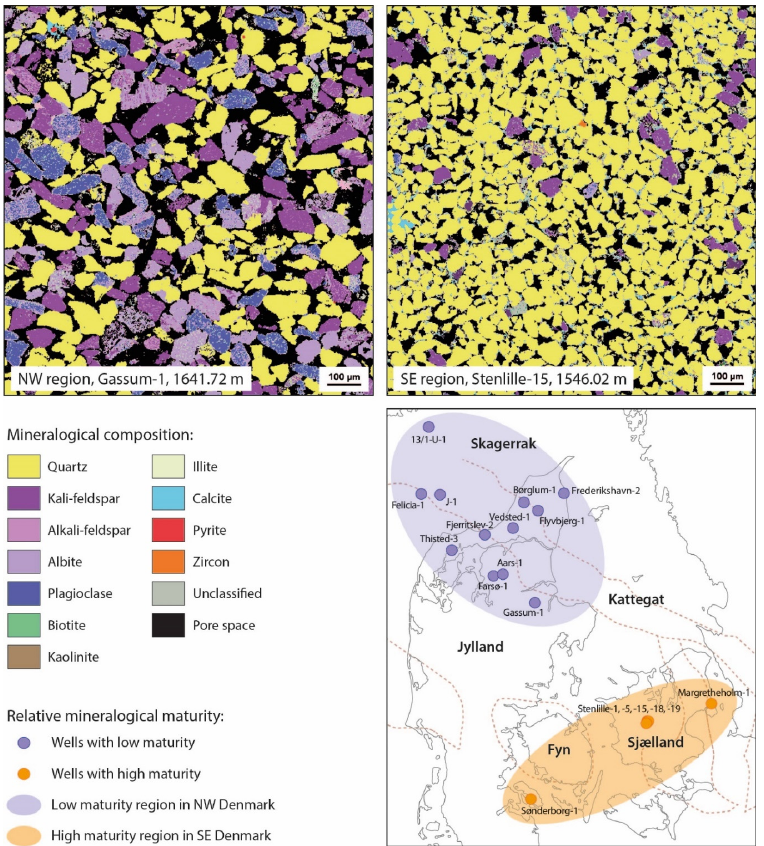
Figure 8. The mineralogical maturity of the Gassum Formation varies across the Danish area. The AQM mineral maps of two sandstone samples show the mature mineralogical composition on Sjælland with high quartz content, whereas a less mature composition with higher contents of especially feldspars is found in Jylland. The map shows where the mineralogical composition of the Gassum Formation has been examined. Based on this information, the formation can be divided into regions with relatively high versus low mineralogical